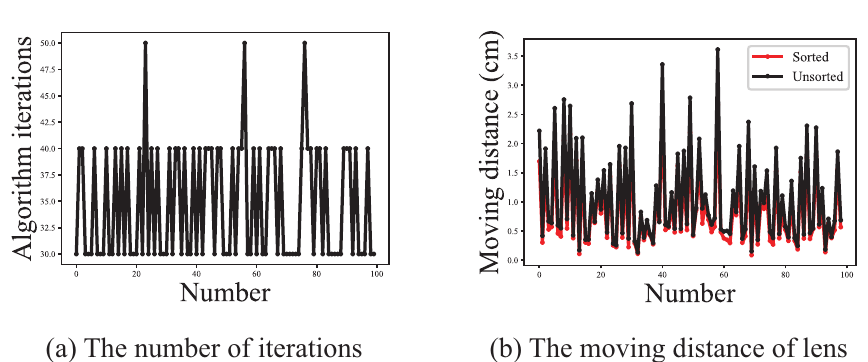
Figure 7. Auto-focus with traversal search.